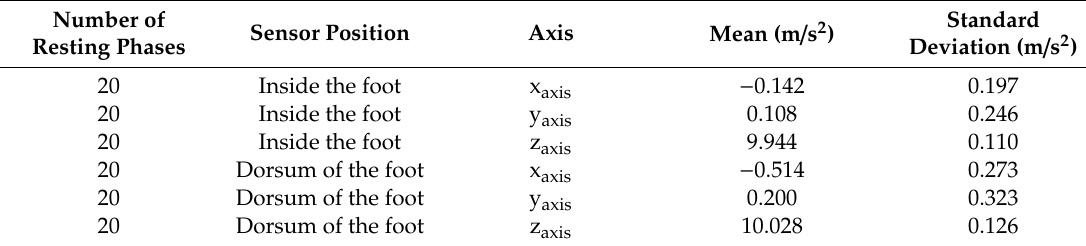
Table 3. Results: acceleration